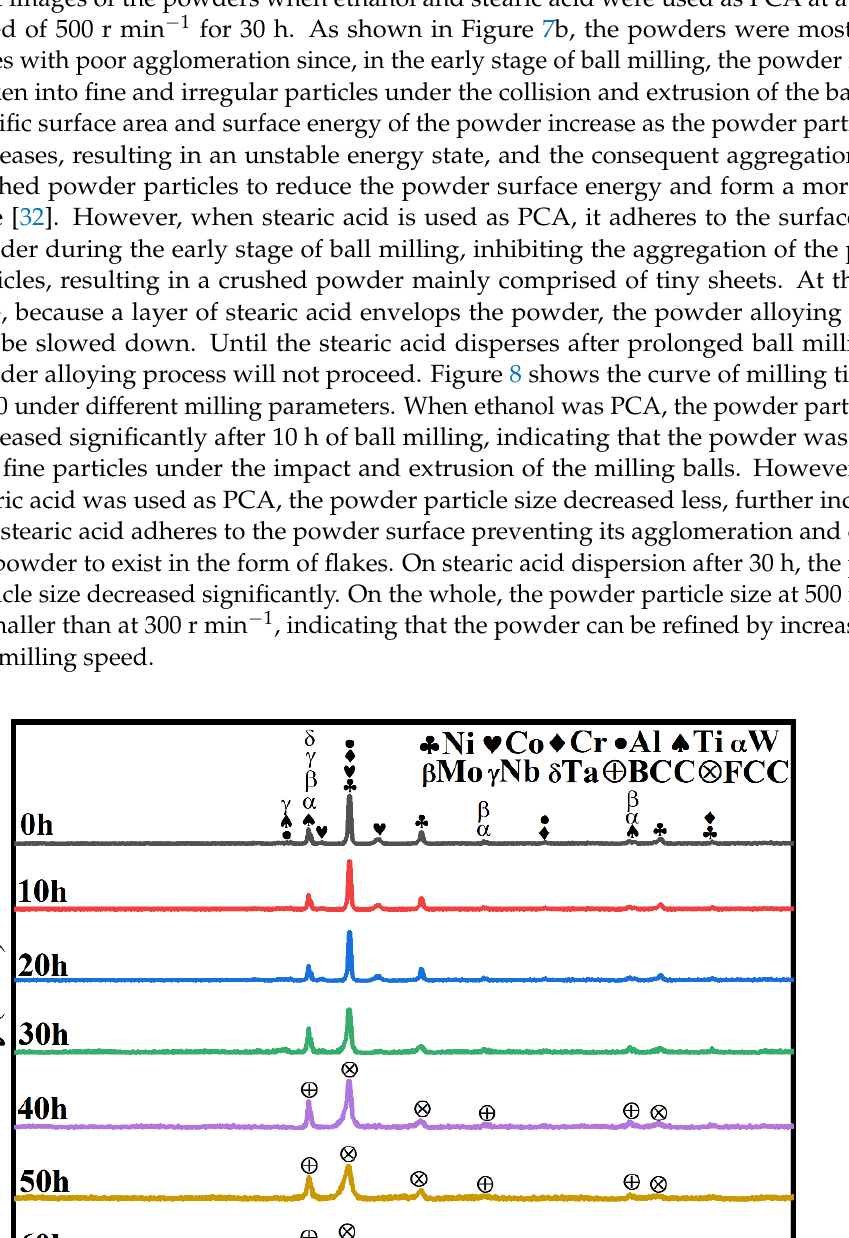
Figure 7. Powder microstructures with different PCA at a milling speed of 500 r min −1 for 30 h: ( a ) ethanol; and ( b ) stearic acid.